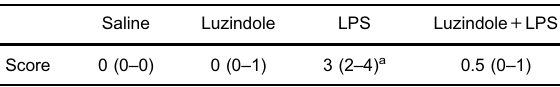
Table 2. Crypt histopathological scores of the experimental mice after treatment with saline, Luzindole, lipopolysaccharide (LPS), and Luzindole + LPS.